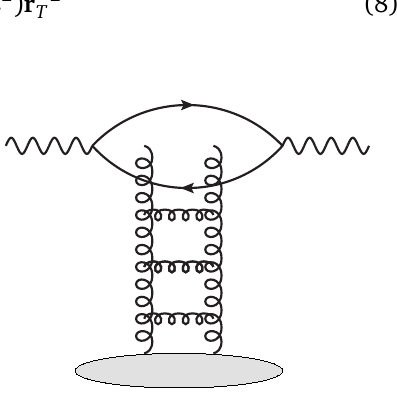
Figure 4: Dipole amplitude in the two gluon exchange